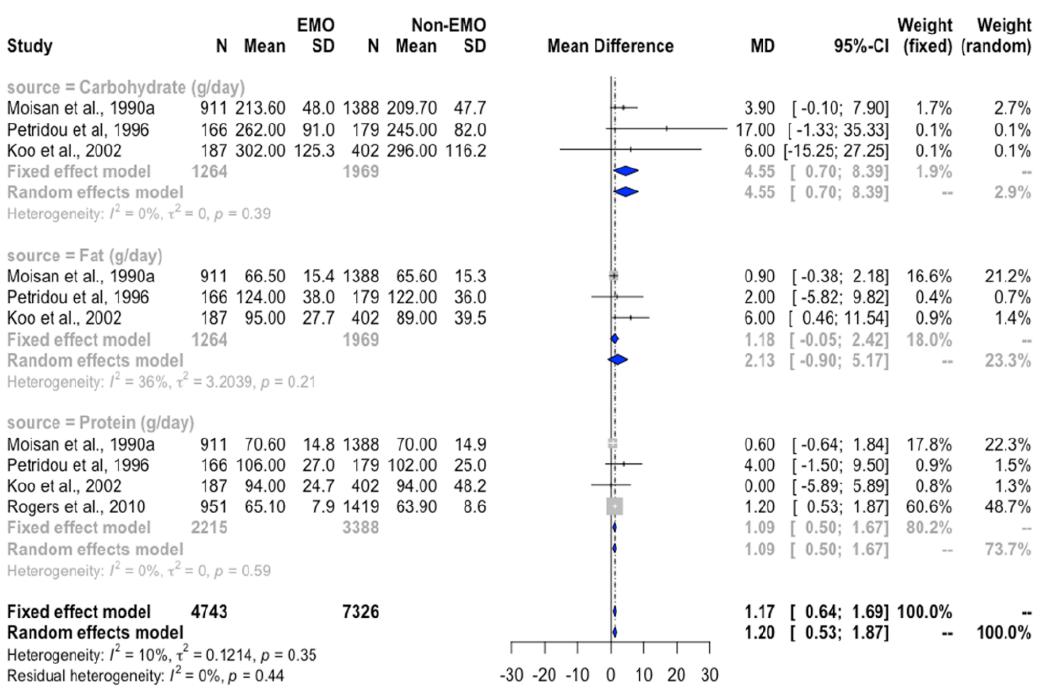
Figure 4. Forest plot of WMD of carbohydrate, protein, and fat intakes between EMO and NEMO groups in healthy girls with BMI 18.5 kg/m 2 . Definition of abbreviations : EMO, earlier menarche onset; NEMO, non–early menarche onset; MD, mean difference; WMD, weighted mean difference. Girls with EMO had higher intake of animal protein [19] than girls with NEMO (MD = 1.4 g/day, 95% CI = 0.7 to 2.1, p < 0.001). Additionally, every 1-g/day increase in animal protein intake in early childhood was linked to approximately 2-month earlier AAM (Figure 5) [13,17,24].